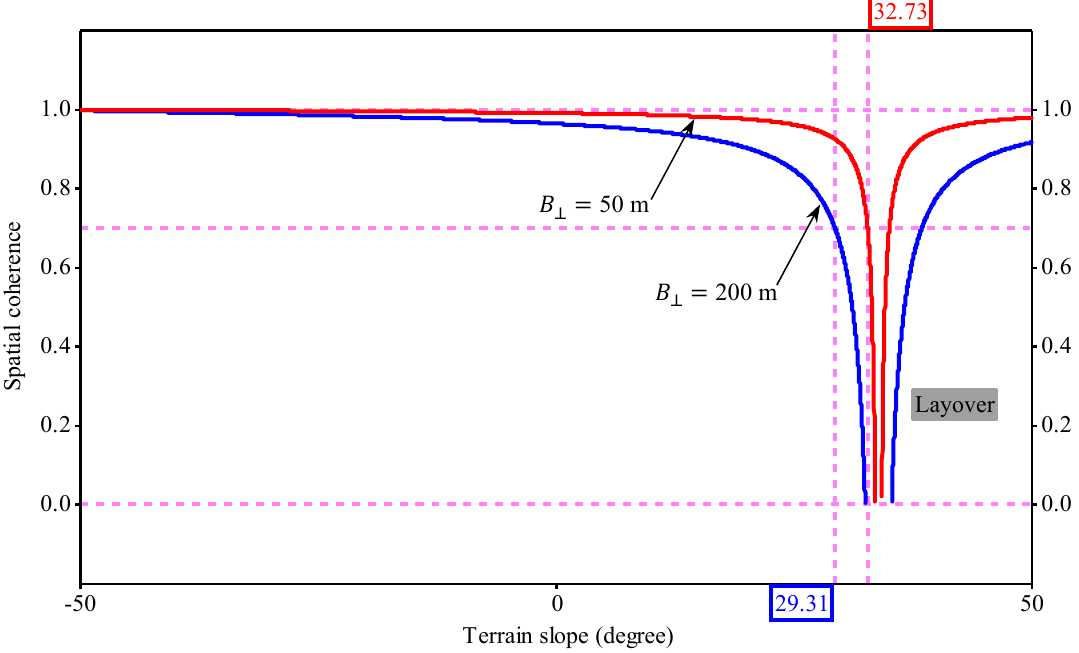
Figure 3. The variation of the spatial coherence represented as a function of the local terrain slope for the two spatial-baseline cases. The red solid curve is for the case of B ⊥ = 50 m, while the blue solid curve is for the case of B ⊥ = 200